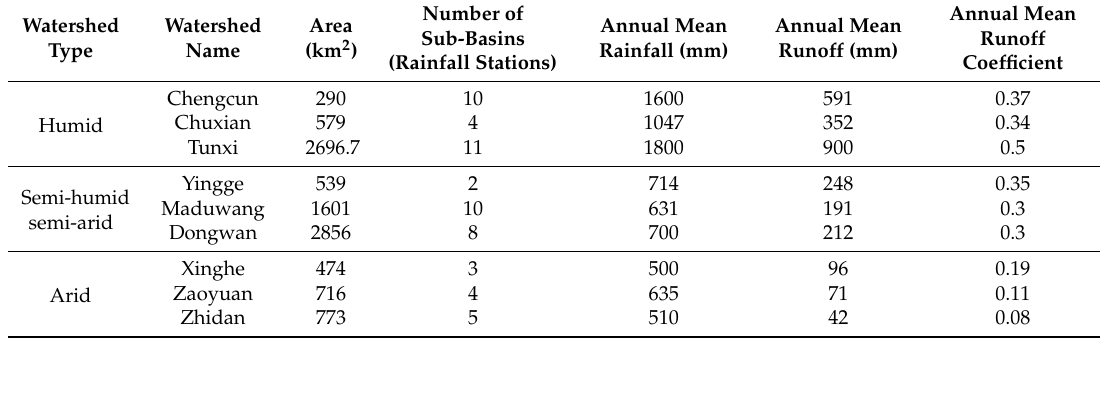
Table 1. Characteristics of the nine study watersheds.